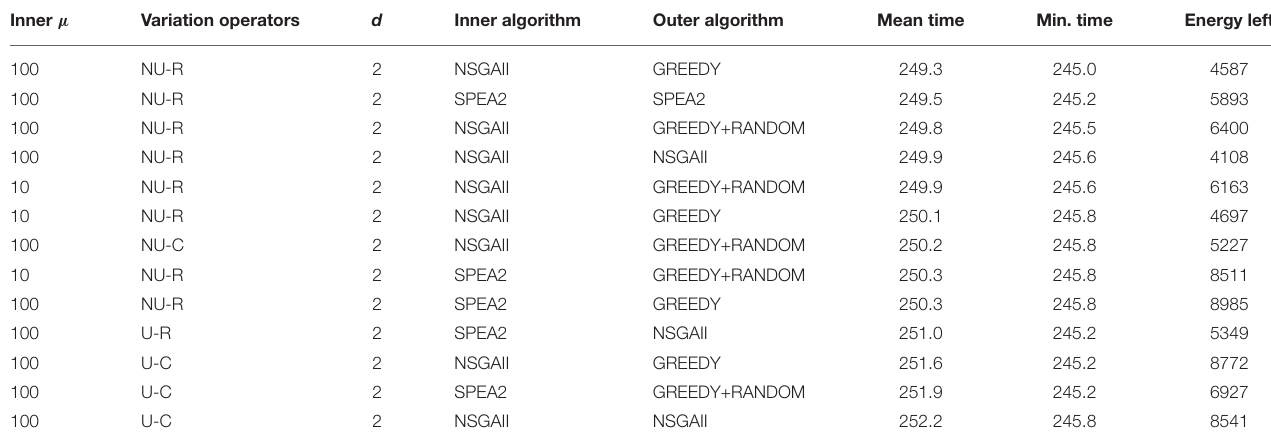
The configurations are sorted based on their mean